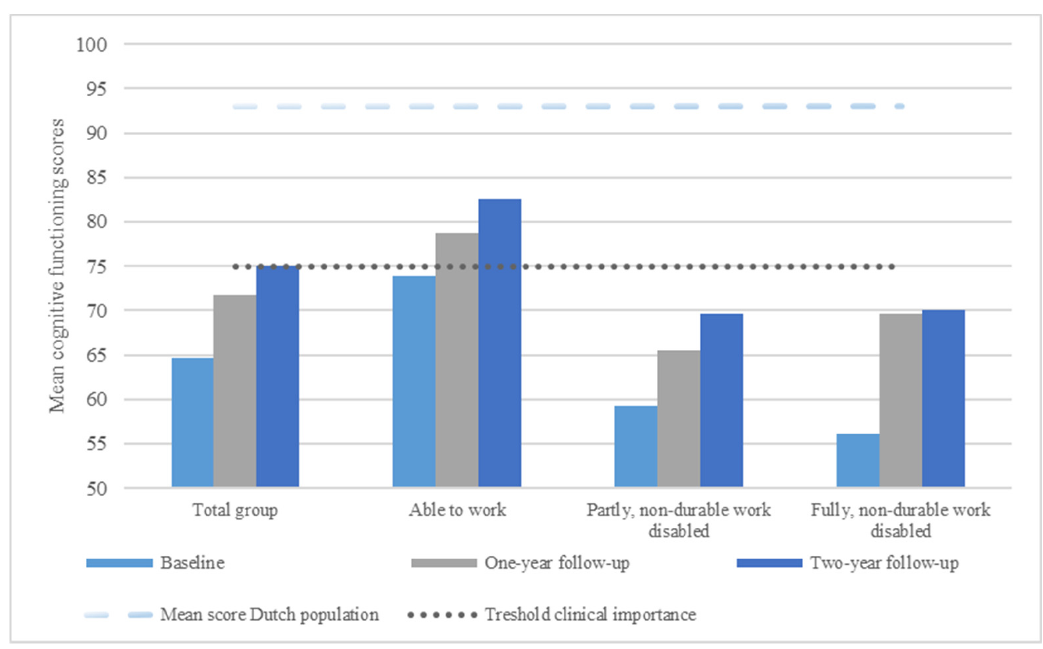
Figure 1. Mean cognitive functioning scores for the total group and separate work disability